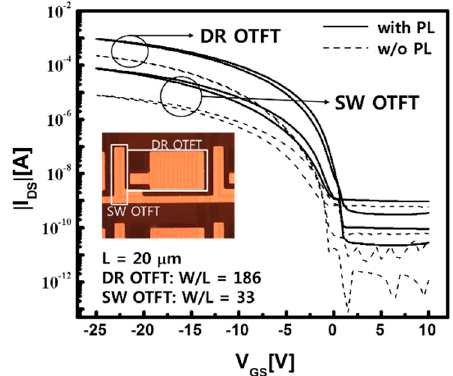
Table 2. The average values of the electrical parameters of the DR and SW OTFTs in the stacked pixel with and without the protection layer.